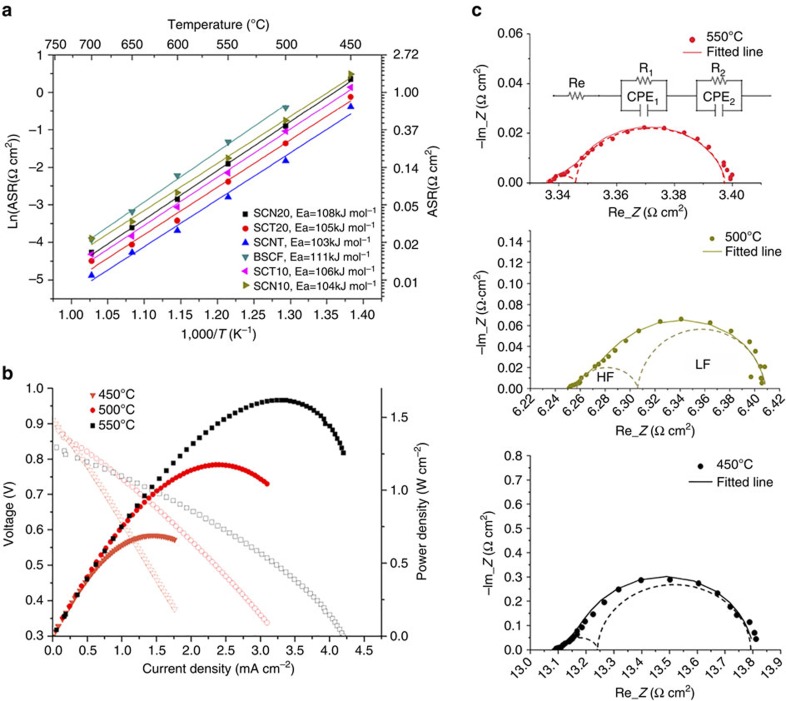
Cathode performance evaluation for the SCNT perovskite.(a) Thermal evolution of the ASR of SCNT, SrCo0.9Nb0.1O3−δ (SCN10), SrCo0.9Ta0.1O3−δ (SCT10), SrCo0.8Nb0.2O3−δ (SCN20), SrCo0.8Ta0.2O3−δ (SCT20) and Ba0.5Sr0.5Co0.8Fe0.2O3−δ (BSCF) cathodes as prepared and studied under the same conditions. Electrochemical impedance spectroscopy (EIS) results using a Sm0.2Ce0.8O1.9 (SDC)-based symmetrical cell. (b) Performance of an anode-supported SCNT | GDC(∼14 μm) | GDC+Ni single cell at 450, 500 and 550 °C with H2 at the anode and flowing air at the cathode. (c) Example Nyquist plots for the SCNT symmetrical cell and the corresponding fitted impedance spectra using a two-process equivalent circuit model.